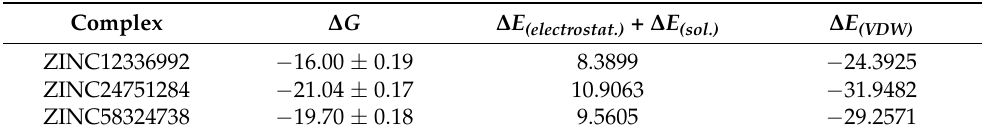
Table 2. Calculated binding free energies of the top three hits (kcal/mol).